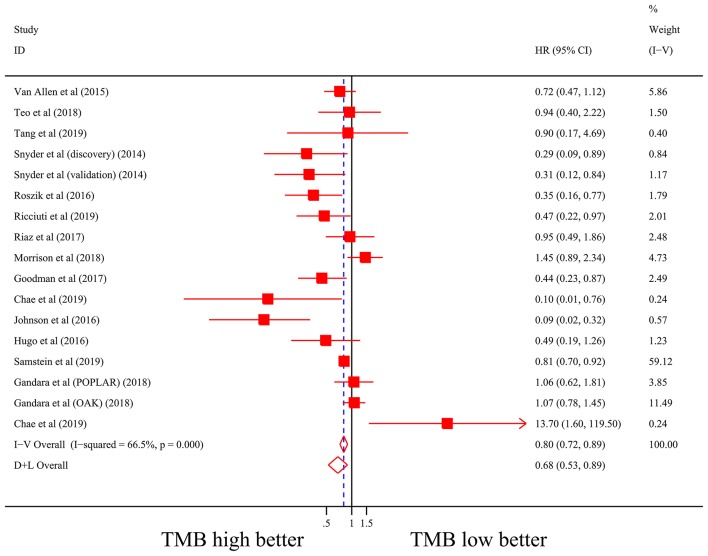
Forest plot of association between TMB and overall survival of immune checkpoint inhibitors. HR, hazard ratio; CI, confidence interval; TMB, tumor mutation burden.